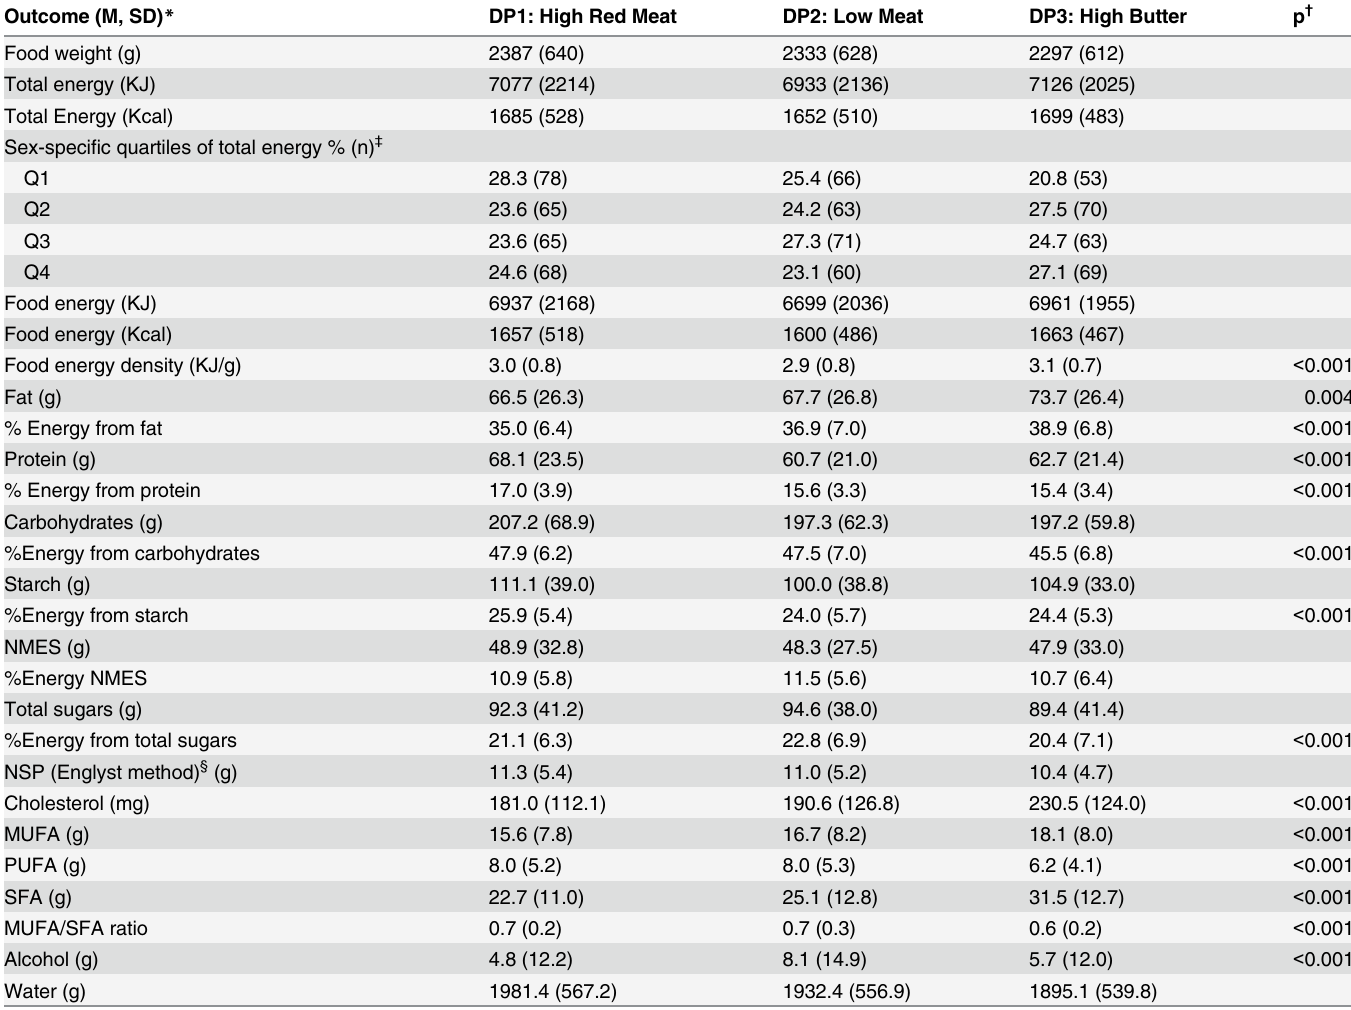
Table 2. Intakes of selected nutrients and energy consumption per day by dietary patterns. Outcome (M, SD) * DP1: High Red